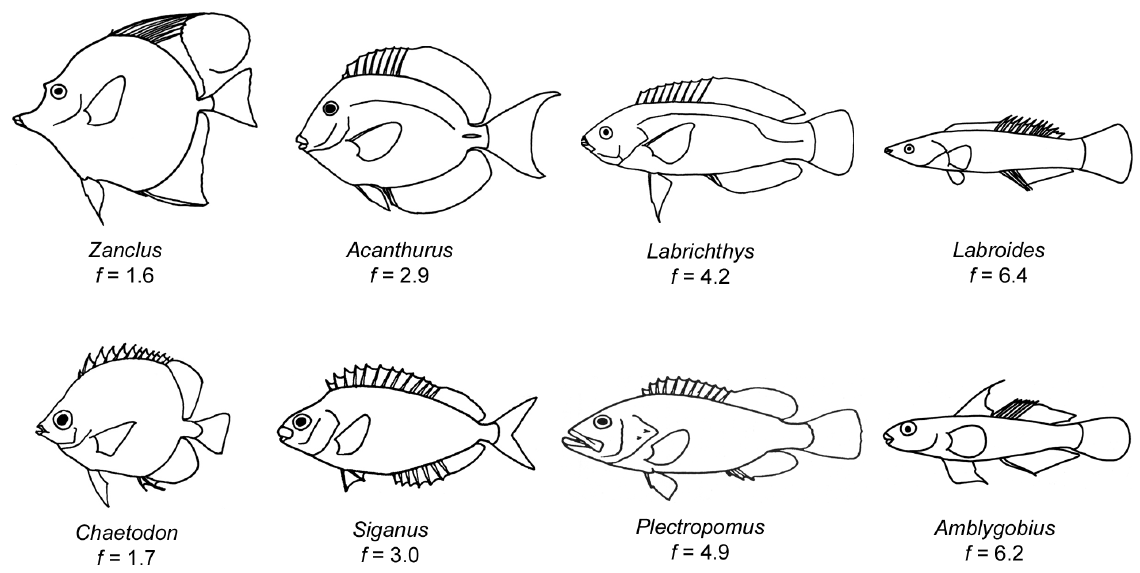
Figure 1. Body shape variation of fishes sampled in this study. The examples show the range of fineness in both pectoral fin (MPF, top row) and body and caudal fin (BCF, bottom row) swimmers.